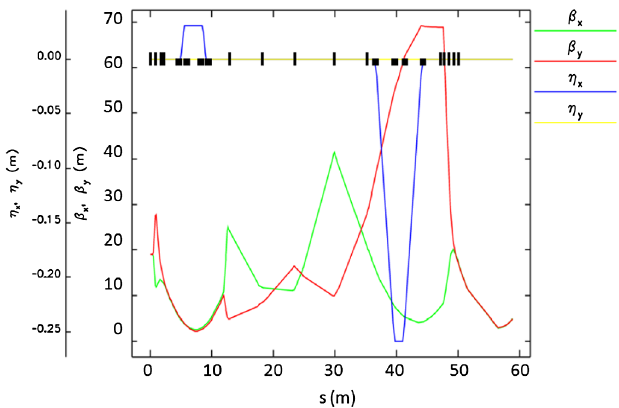
FIG. 3. Design optics from the LH to the BC1 area (the negative horizontal dispersion is inside BC1). The small upright rectangles represent quadrupole magnets while squares are dipole